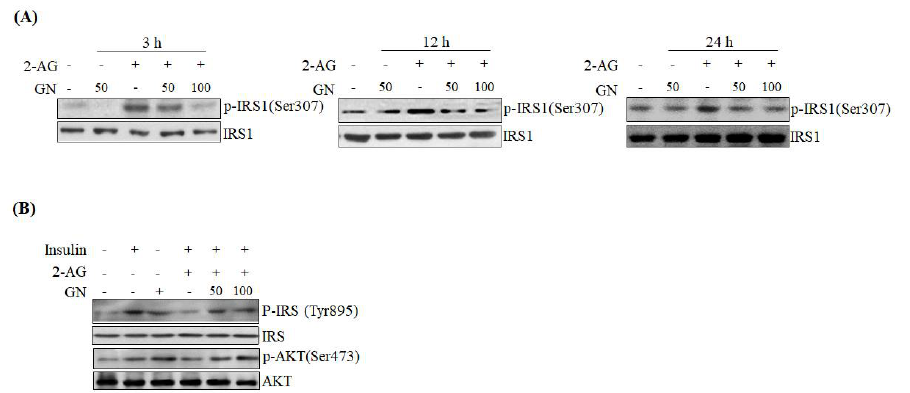
Figure 3. GN improved 2-AG-mediated inhibition of insulin signaling in HepG2 cells. ( A ) HepG2 cells were incubated with 2-AG in the absence or presence of GN (50 or 100 µM) for 3, 12 and 24 h. Serine-307 phosphorylation of IRS1 was detected by western blot analysis; ( B ) HepG2 cells were incubated with 2-AG in the absence or presence of GN (50 or 100 µM) for 12 h, and then incubated with insulin (10 nM) for 30 min. The phosphorylation of IRS1 (tyrosine-895) and AKT (serine-473) was detected by western blot analysis.